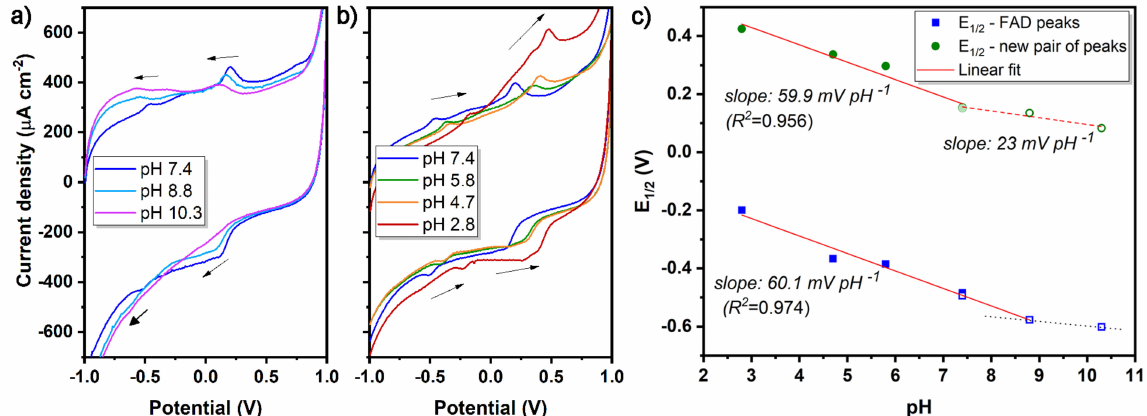
Figure 6. Cyclic voltamograms (100 mV s − 1 ) of LIG/GOx varying the pH from ( a ) pH 7.4 to 10.3 and from ( b ) pH 7.4 to 2.8. ( c ) Half-wave potential (E 1/2 ) of the new pair of peaks and the one corresponding to free FAD in function of the pH. In ( c ) the open and the closed symbols correspond to the data from ( a ) and ( b ), respectively. The dotted black line aids in guiding the eye to observe the change in the slope. All the measurements were performed in phosphate containing solutions with the same ionic strength (NaCl 0.137 M and KCl 0.027 M), in the absence of O 2